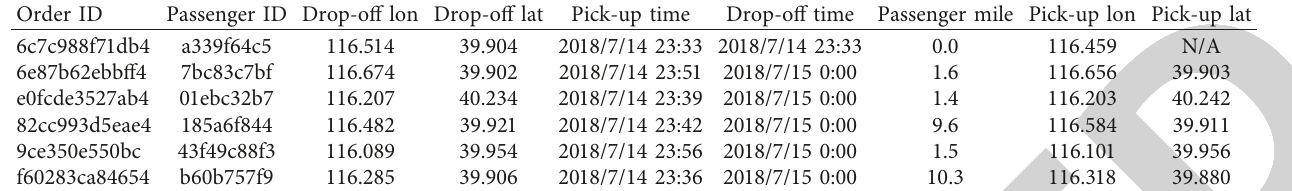
Table 1: Sample of car-hailing data.